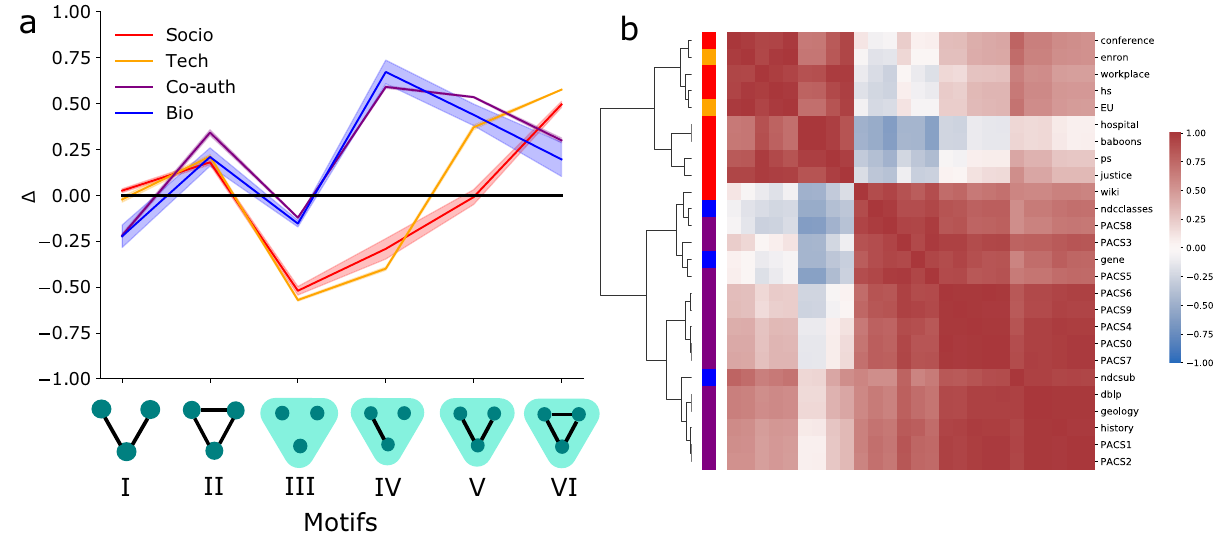
Fig. 2 A higher-order fi ngerprint for hypergraphs at the network microscale. a Signi fi cance pro fi les (SP) of hypergraphs from higher-order motifs of order 3 (labeled I – VI). Δ is the abundance of each motif relative to random networks. Over-expressed higher-order motifs are associated to speci fi c functionalities of the system. To simplify the plot, we averaged and grouped higher-order motif pro fi les of networks from the same domain. For each domain, we represent the mean of the respective higher-order motif pro fi les with a solid line and the standard error of the mean with a shaded area. b Correlation matrix of the investigated datasets computed on the SPs. SPs of networks from similar domains display a positive correlation. We identify two large higher-order families of hypergraphs, characterized by distinct higher-order connectivity patterns at the local scale. Each row of the correlation matrix is labeled with different colors depending on the domain of the respective dataset: red for the social domain, orange for e-mails, purple for the co- authorship domain and blue for the biological domain. Moreover, we show the clustering tree computed by applying a hierarchical clustering algorithm on the signi fi cance pro fi les, considering correlation as a measure of similarity. The clustering tree highlights the hierarchical organization of the emerged clusters. In the correlation matrix, red squares represent high positive correlation while blue squares represent high negative